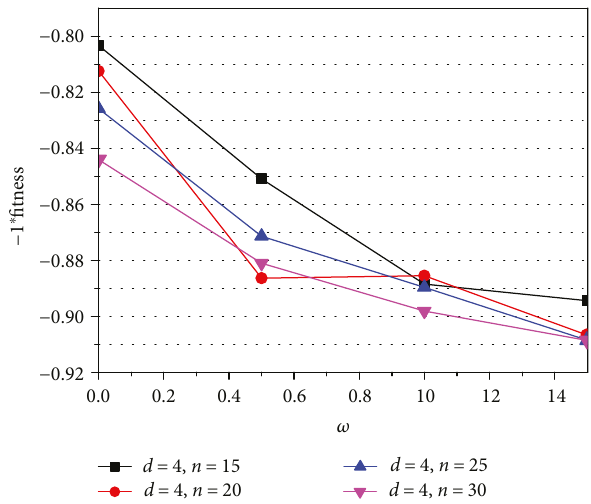
Figure 5: Joint parameter sensitivity test for ω and n of the ICSDC for the scheme.